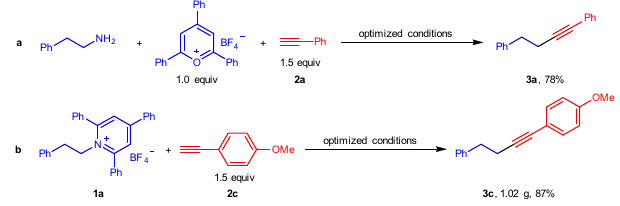
Fig. 4 Further applications. a One-pot transformation. b Gram-scale